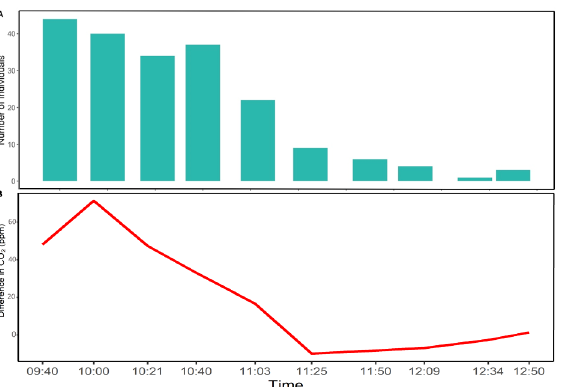
Fig 1. Number of individuals (A) and the difference in CO 2 concentration (ppm) between the indoor and outdoor meters (B) over time.